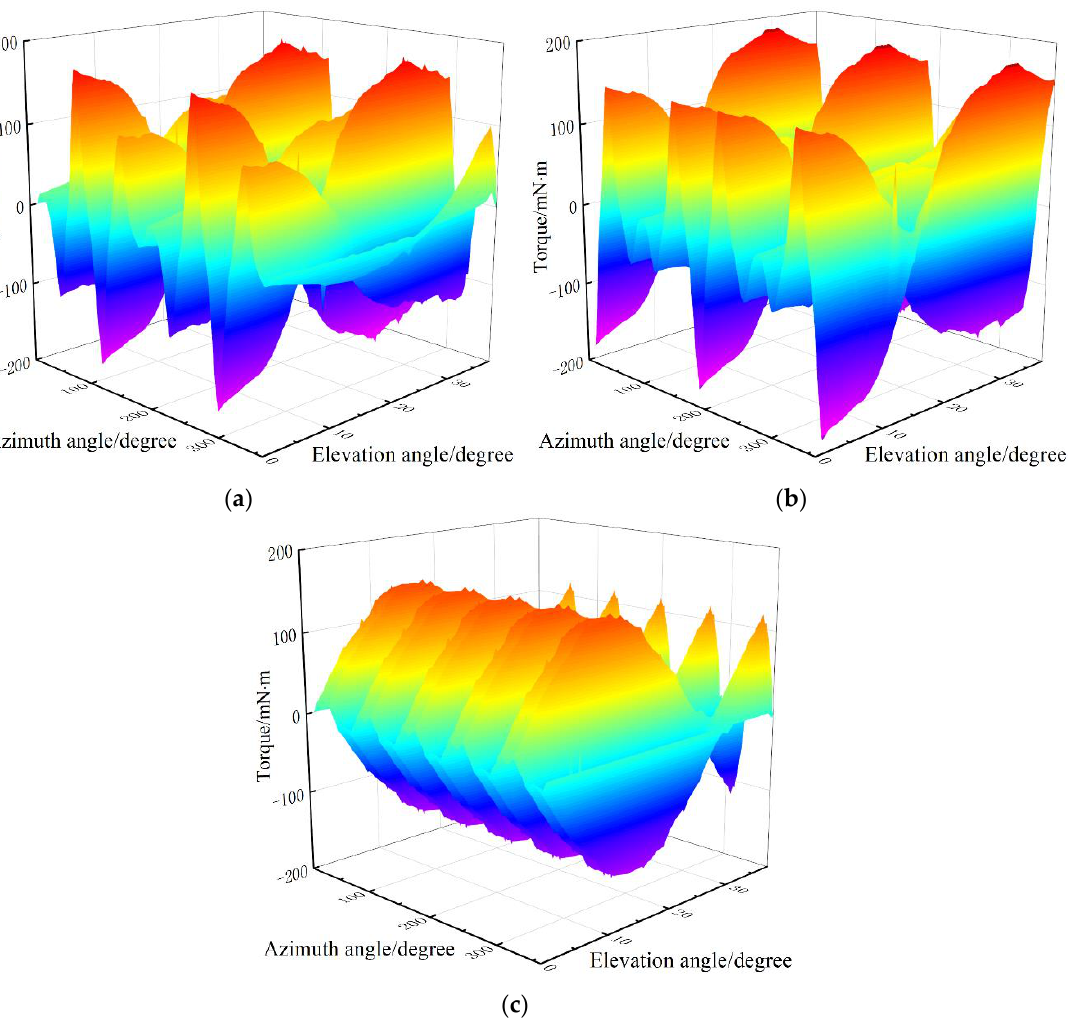
Figure 3. The torque map of the PMSpA: ( a )Spinning torque, ( b ) Pitching torque, and ( c ) Yawing torque.